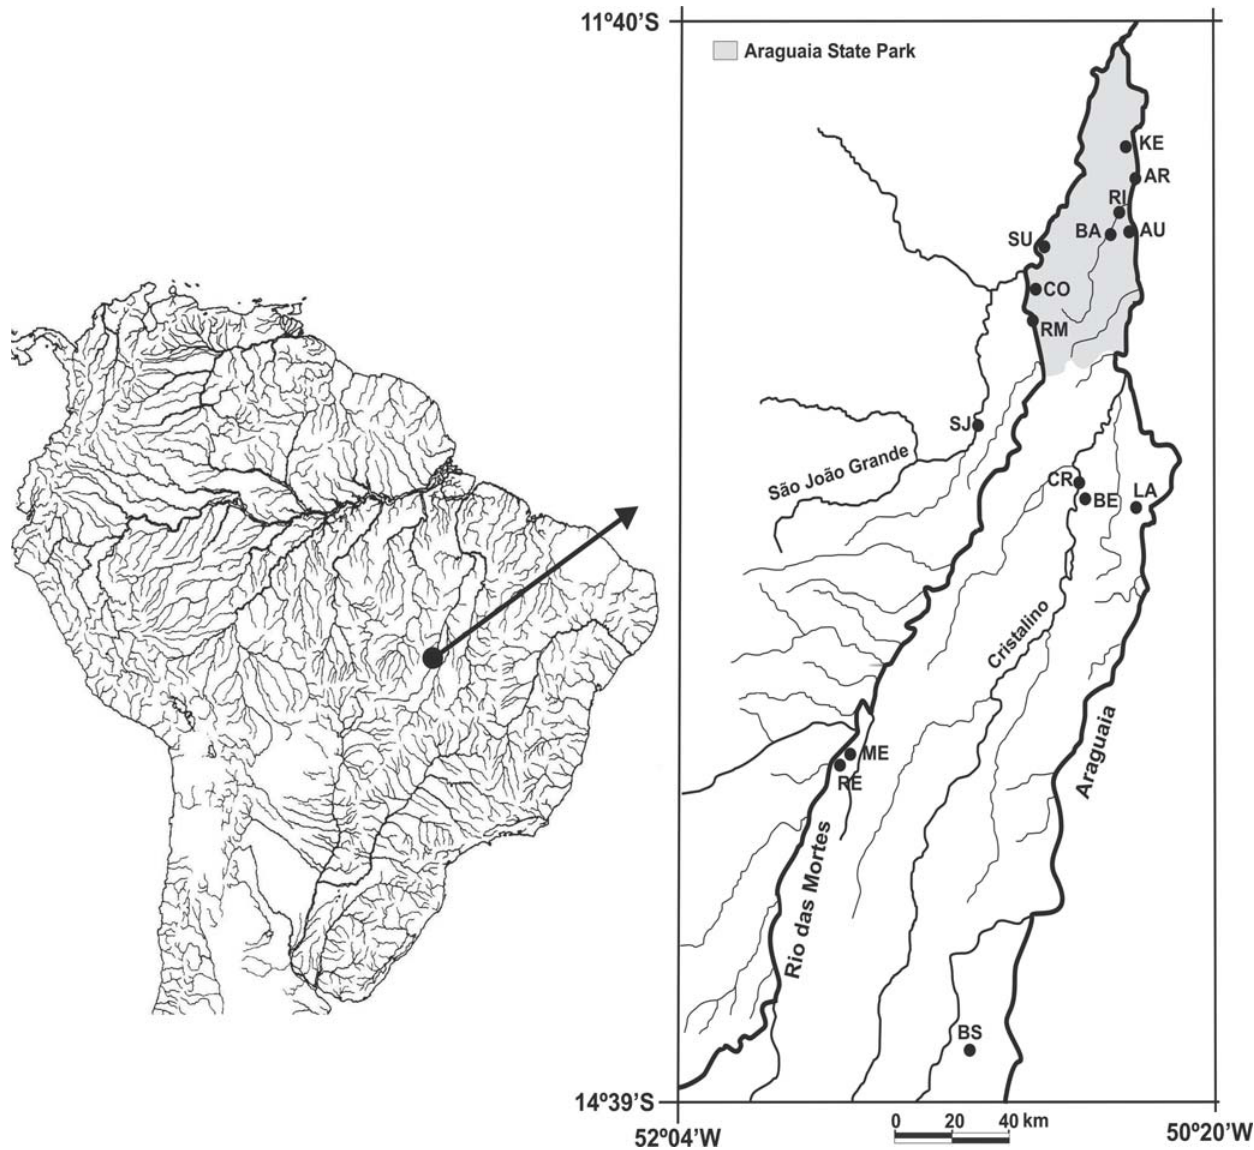
Fig. 1. Partial map of South America showing the location of the study area in the Bananal floodplain. The detailed map depicts the sampling sites (circles) in the rios Araguaia and Mortes basins. See Table 1 for site